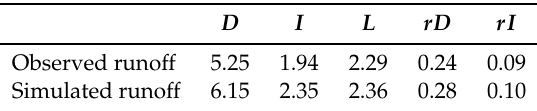
Table 2. Validation of simulated deficit volumes. D : severity, I : intensity, L : length, rD : relative severity and rI : relative intensity.